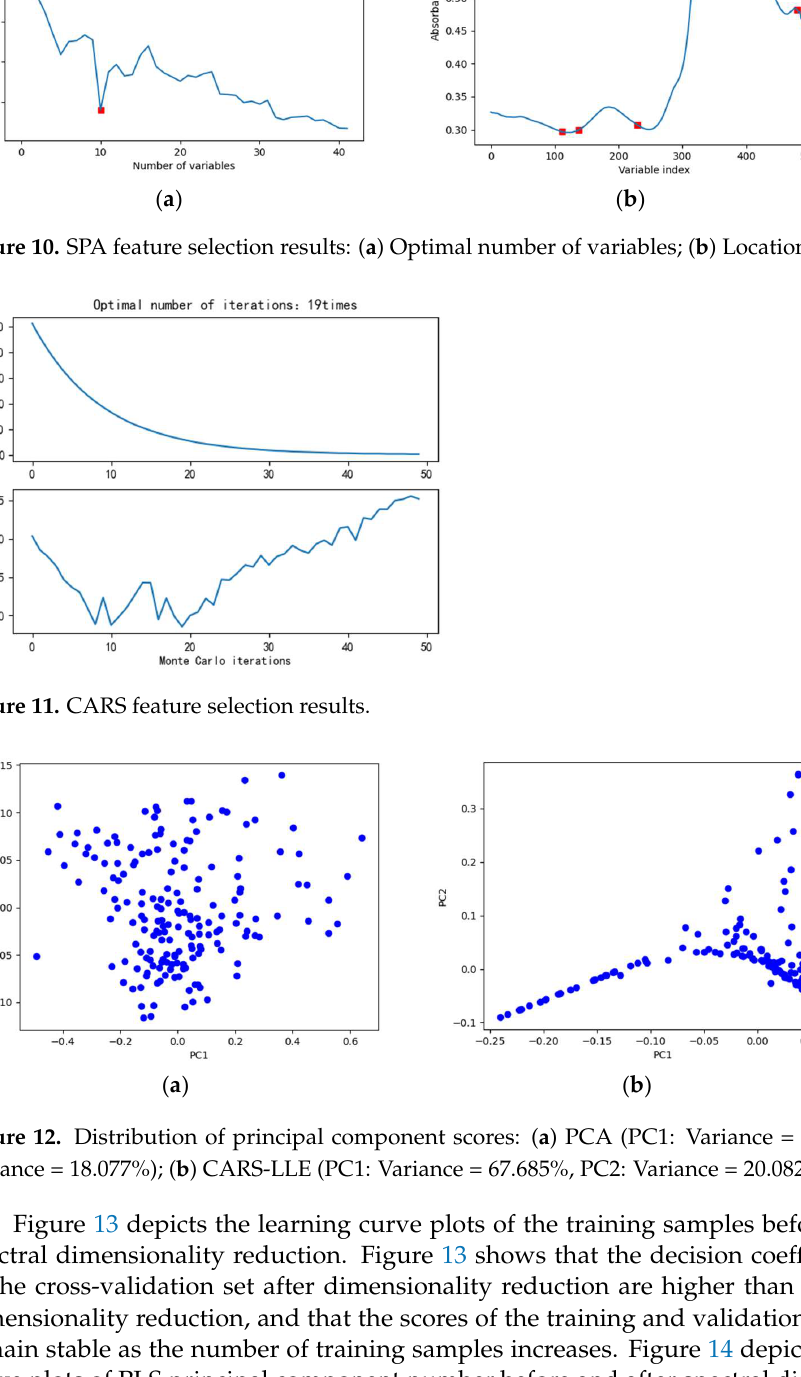
( b ) Figure 13. Learning curve of training samples: ( a ) Before dimension reduction; ( b ) After dimension reduction with CARS-LLE.